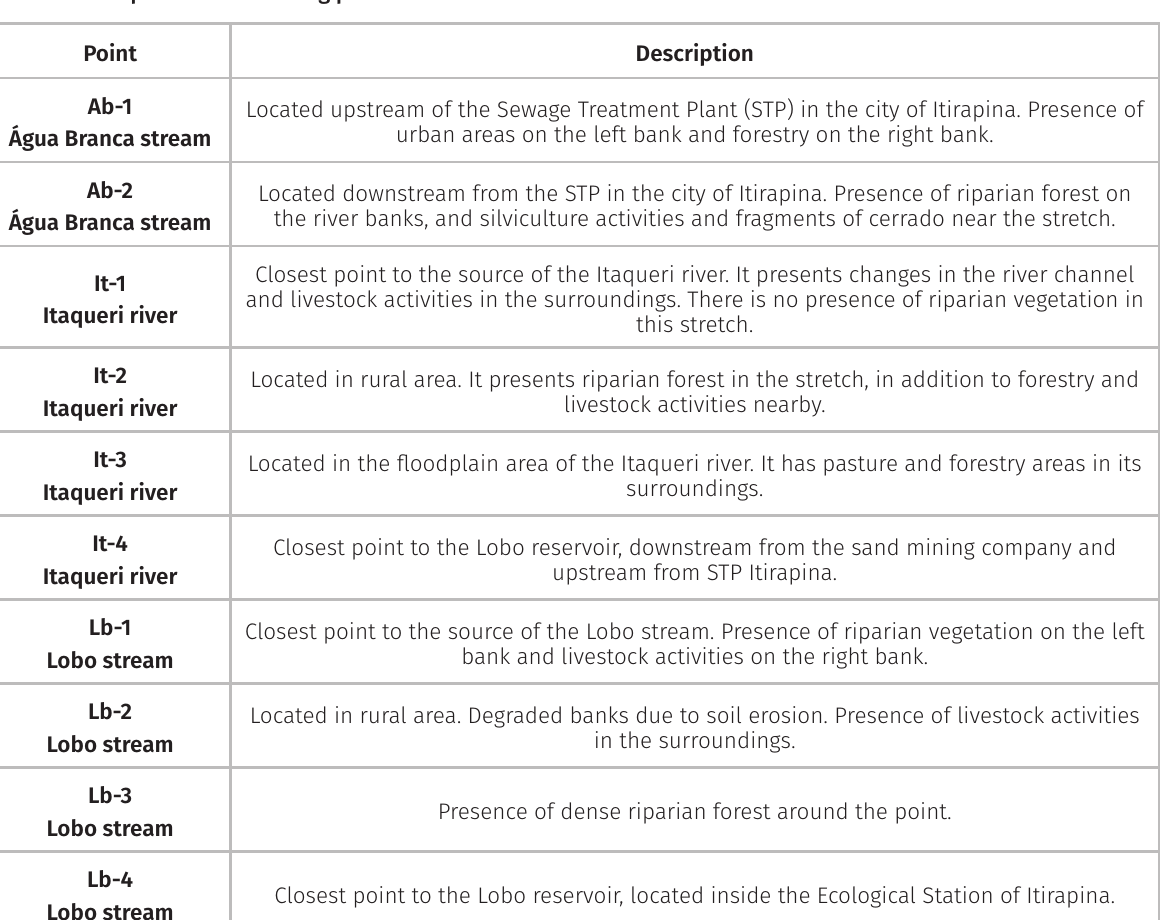
Table I. Description of monitoring points at LSRB